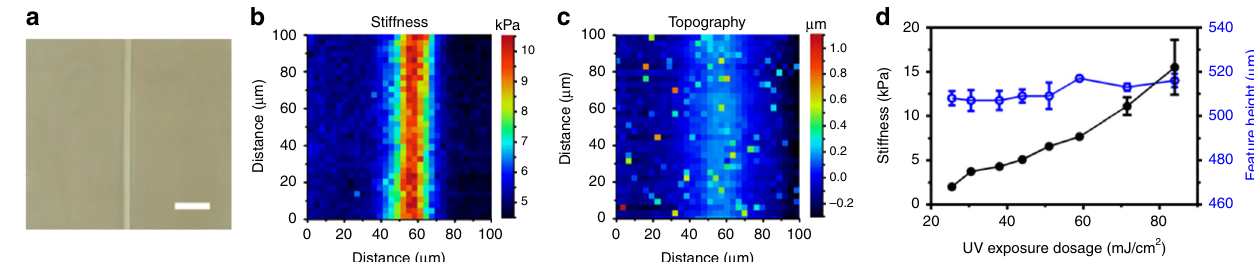
Fig. 2 Programmed stiffness of photo-curable hydrogels. a Bright- fi eld optical image of a stiff line feature (UV exposure dosage of 72 mJ cm − 2 ) in a soft hydrogel background (UV exposure dosage of 44 mJ cm − 2 ). Scale bar is 100 μ m. The total thickness is ~500 μ m to improve the accuracy of